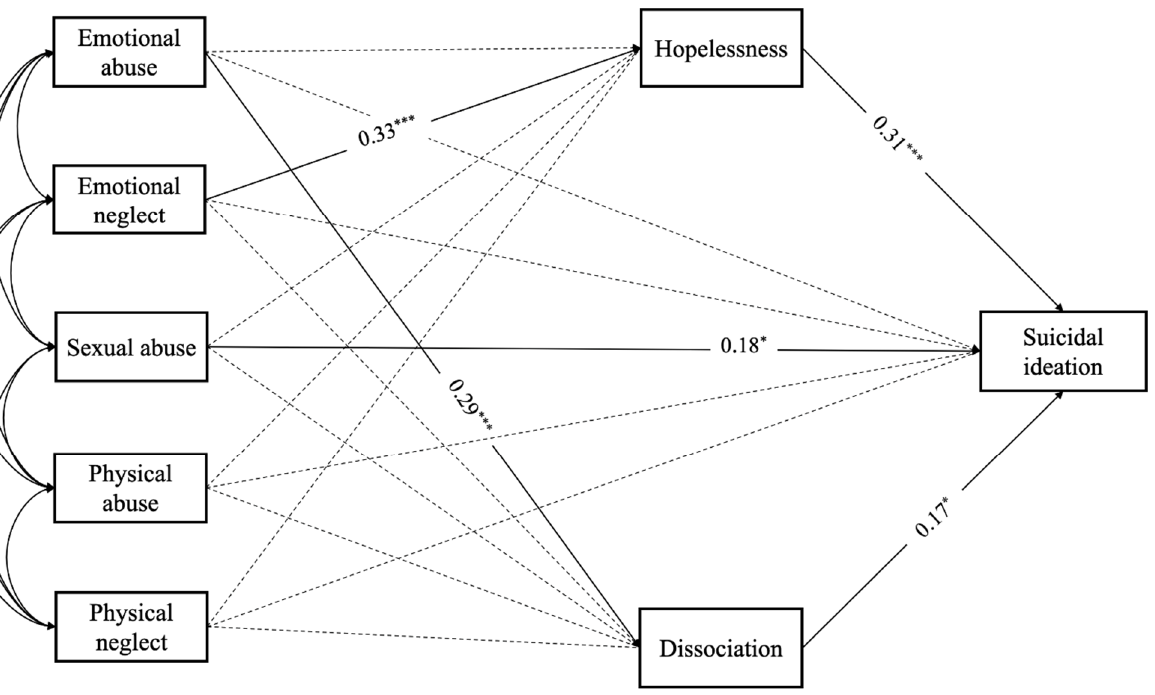
Figure 1. Path analysis. All reported parameters are standardized. * p < 0.05; *** p < 0.001. For ease of interpretation, the effects of covariates are not shown in the figure.